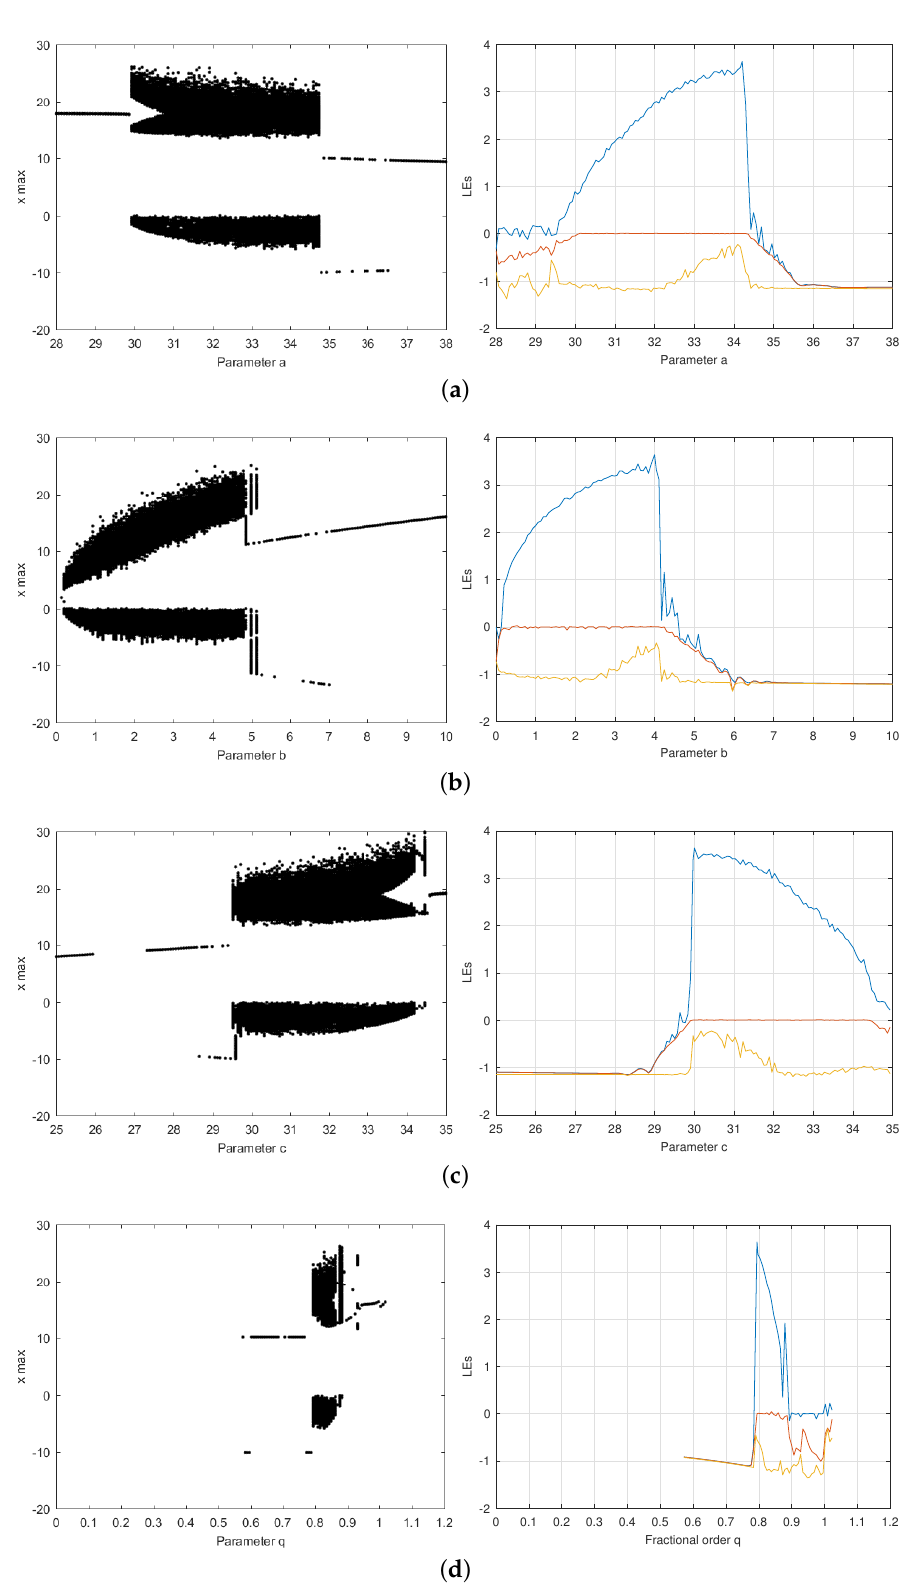
Figure 5. Bifurcation diagram and LE spectra of fractional order Chen system for PSO best result at 450 and 500 generations. For the LE spectra, L 1 is in blue color, L 2 in red, and L 3 in yellow. a = 34.2041, b = 3.9948, c = 30.0000, q = 0.7939 and MLE = 3.6381. ( a ) Parameter a ( b ) Parameter b ( c ) Parameter c ( d ) Fractional order q